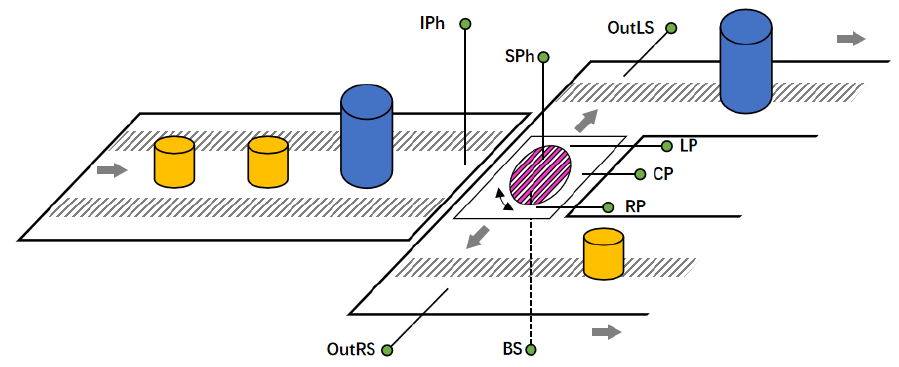
Figure 6. A product sorter.